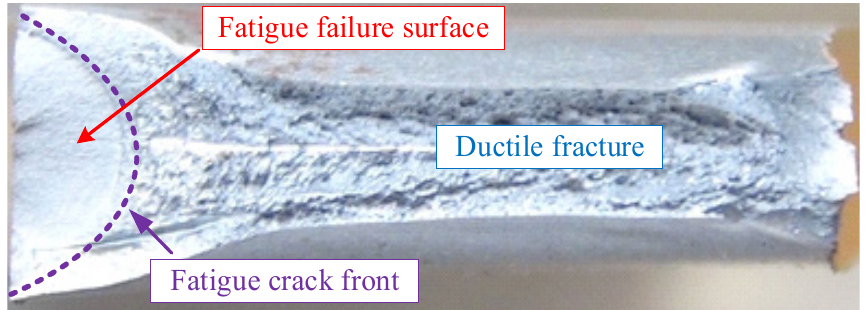
Figure 10. Simulated evolutions of the fatigue crack surface.